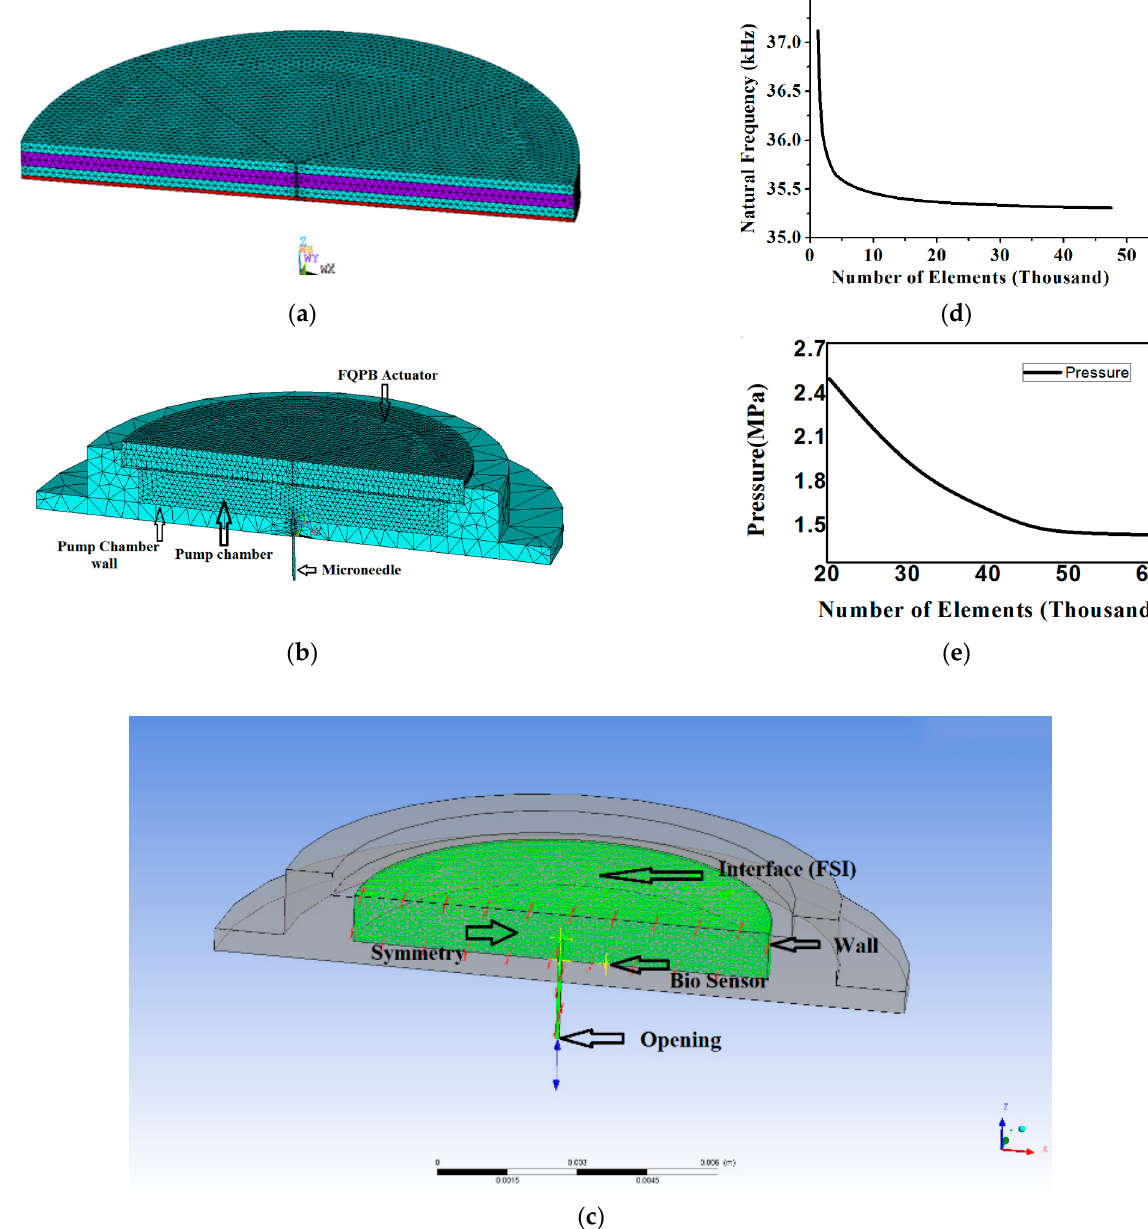
Figure 2. ( a ) Meshing of the FQPB actuator with silicon diaphragm, ( b ) meshing of the complete micropump, ( c ) boundary conditions at various interfaces, ( d ) mesh independency test of the actuator, and ( e ) mesh independency test of the complete micropump.